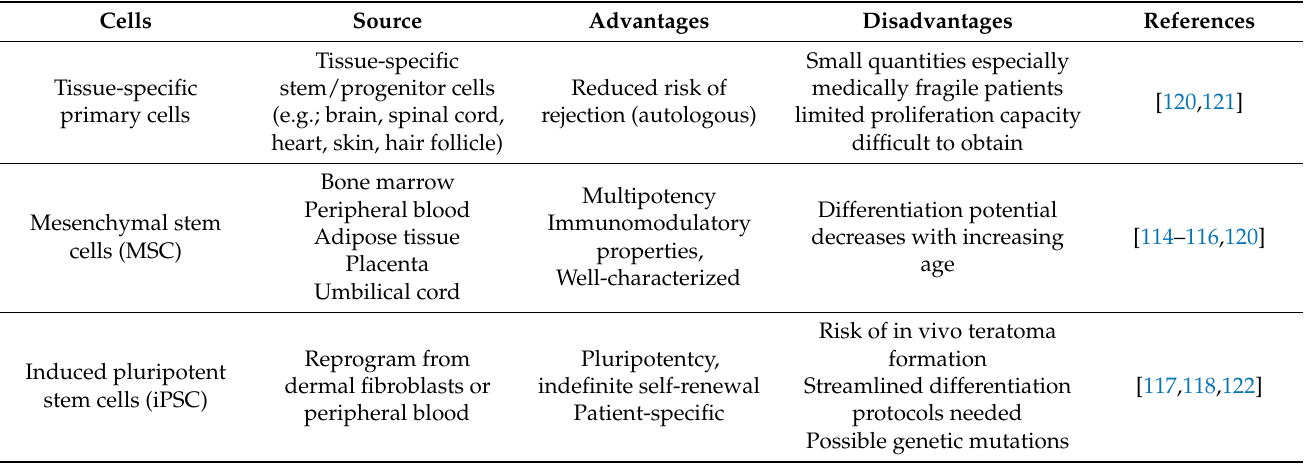
Table 3. Advantages and Disadvantages of the Main Cell